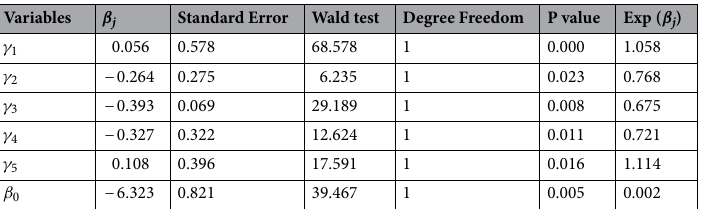
Table 5. The value of model parameters (HR%, PM 2.5 concentration, gender, age and BMI). The statistical value is the mean value of the